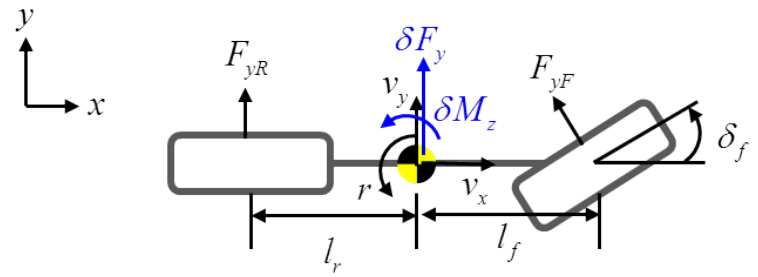
Figure 1. The 2-DOF bicycle